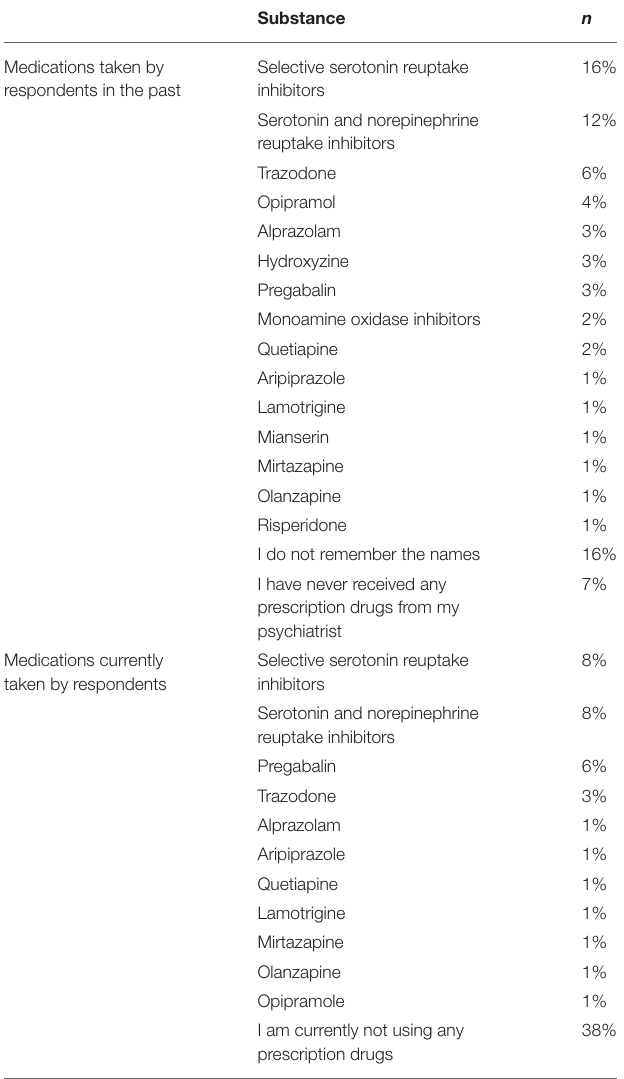
TABLE 4 | Psychiatric medications taken by respondents. Substance n Medications taken by respondents in the